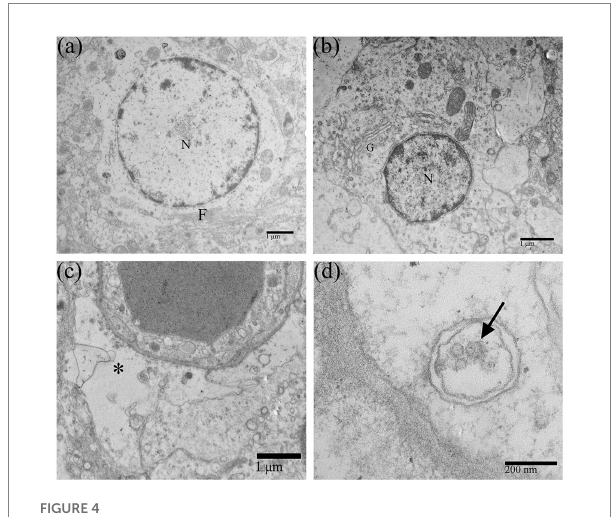
FIGURE 4 Morphological changes of neuroglial cells in DTMUV-infected duckling brains. (A) Astrocyte. (B) Oligodendrocyte. (C) The astrocytic foot process was swollen, and the glial filaments in the foot process were dissolved and disappeared. (D) DTMUV virions (arrow) were encapsulated in vesicles within the astrocytic foot process. G, Golgi apparatus; F, Glial filament. * Astrocytic foot process. N, nucleus.